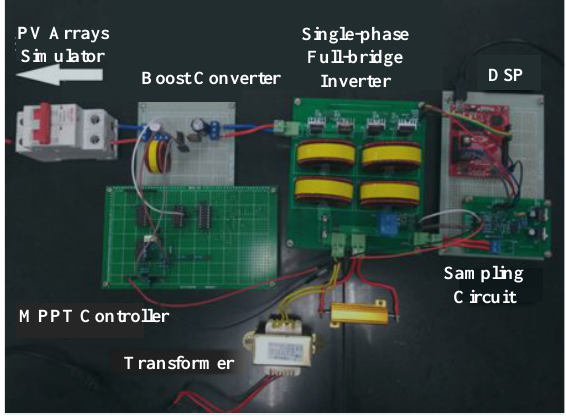
Figure 9. Experimental setup.